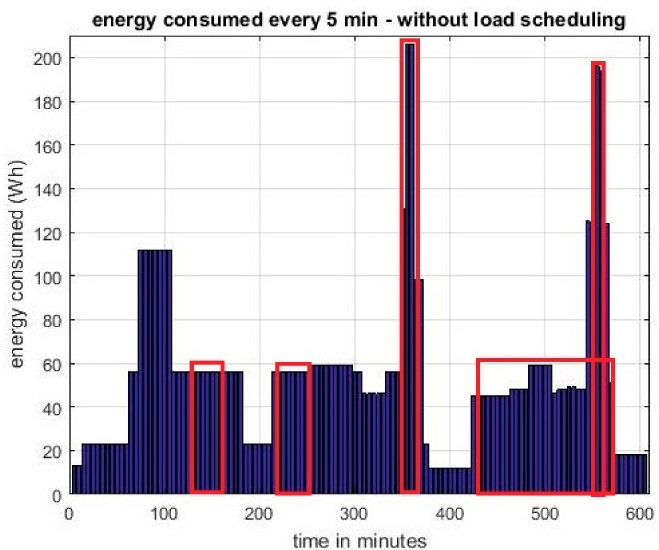
Figure 10. Energy consumption without load scheduling and control—expected changes at time slots shown with red